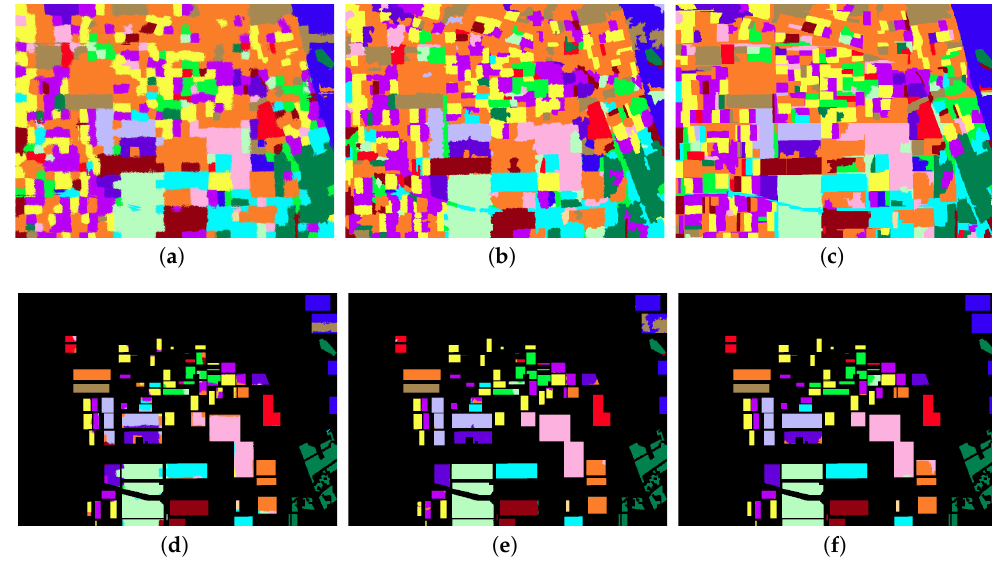
Figure 19. The visual classification results on Flevoland data set. ( a ) The classification map by QSLIC. ( b ) The classification map by QSEEDs. ( c ) The classification map by QPAN. ( d ) The classification map ( a ) overlaid with the ground truth map. ( e ) The classification map ( b ) overlaid with the ground truth map. ( f ) The classification map ( c ) overlaid with the ground truth map.